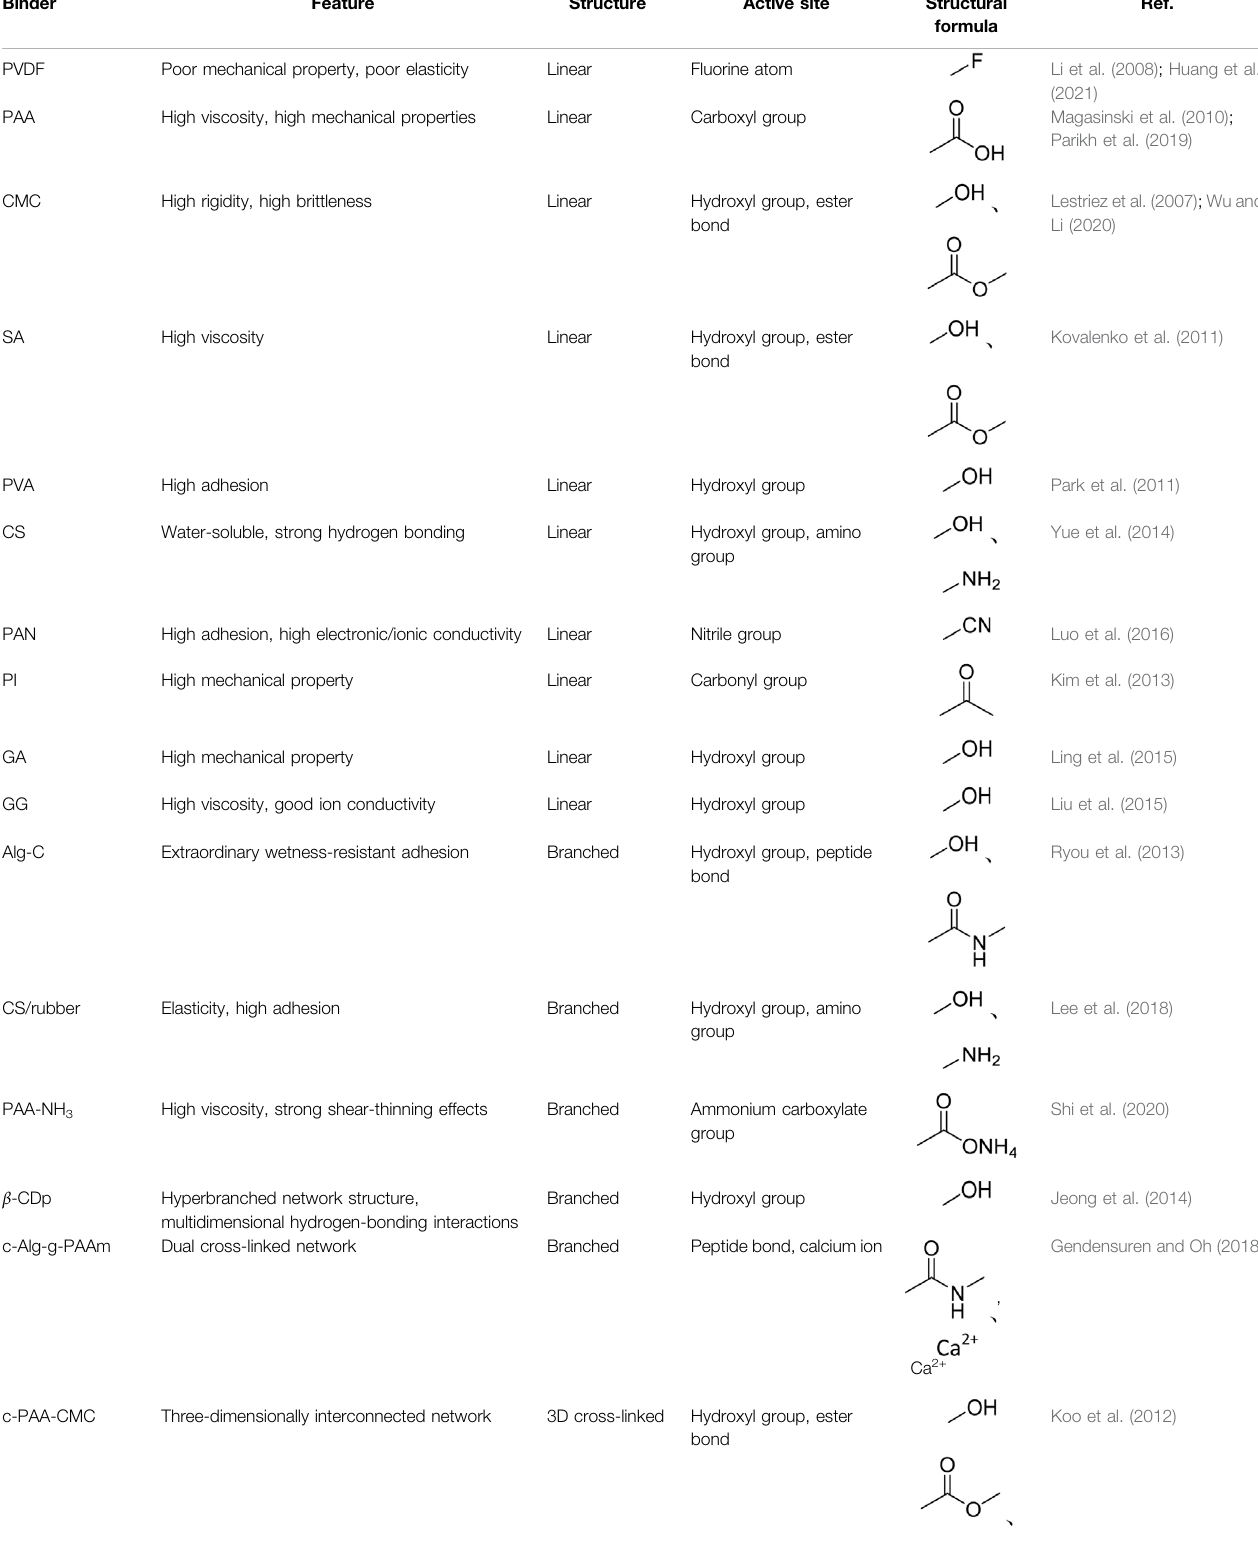
TABLE 1 | The structures and key properties of various binders for Si-based